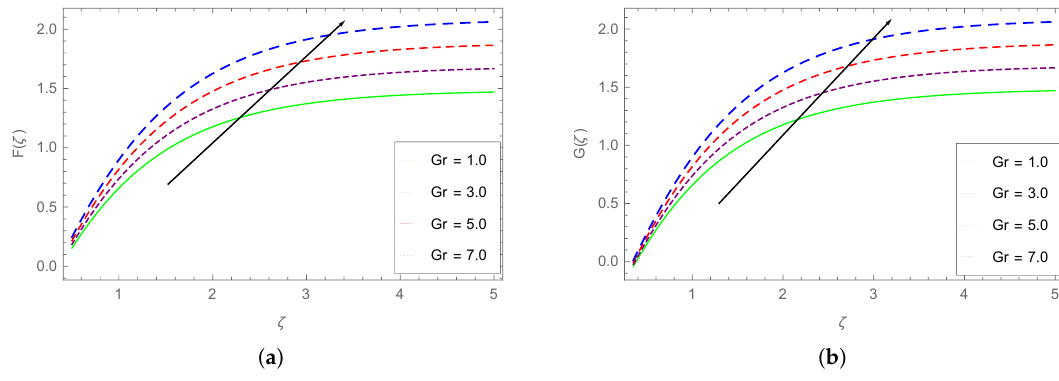
Figure 10. Impact of Gr on ( a ) F ( ζ ) and ( b ) G ( ζ ) .